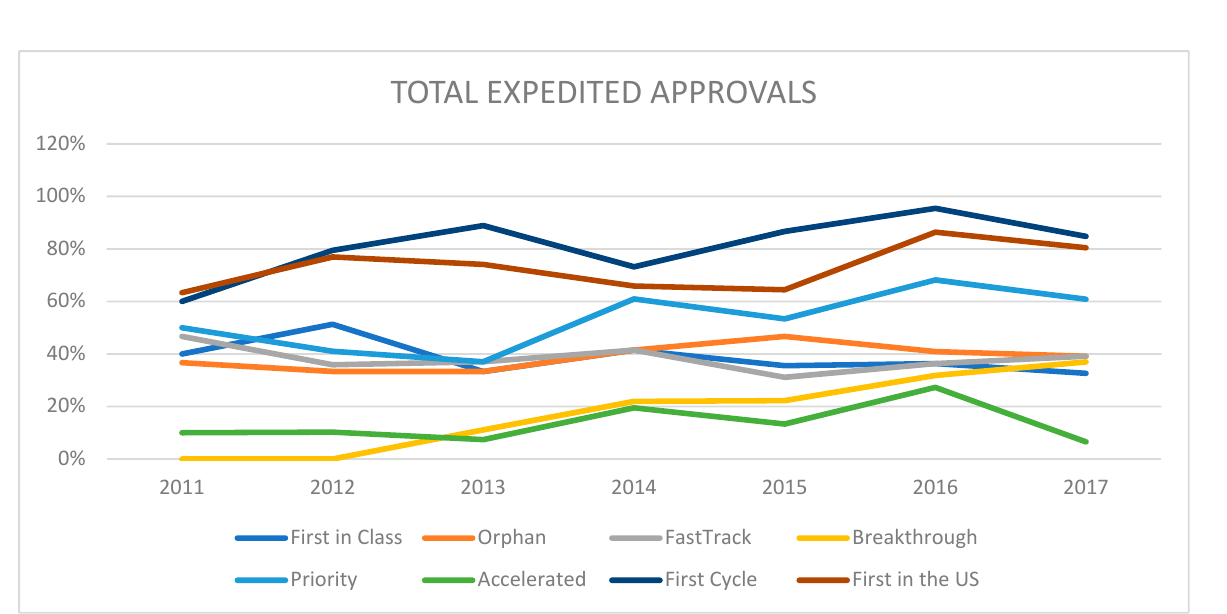
Figure 2. Time trend analysis showing relative percentage of expedited development and FDA review programs granted to each newly approved NME from 2011–2017. Drugs can be associated with more than one program.